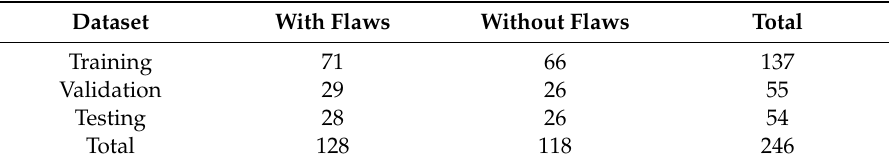
Table 1. Number of training, validation, and testing